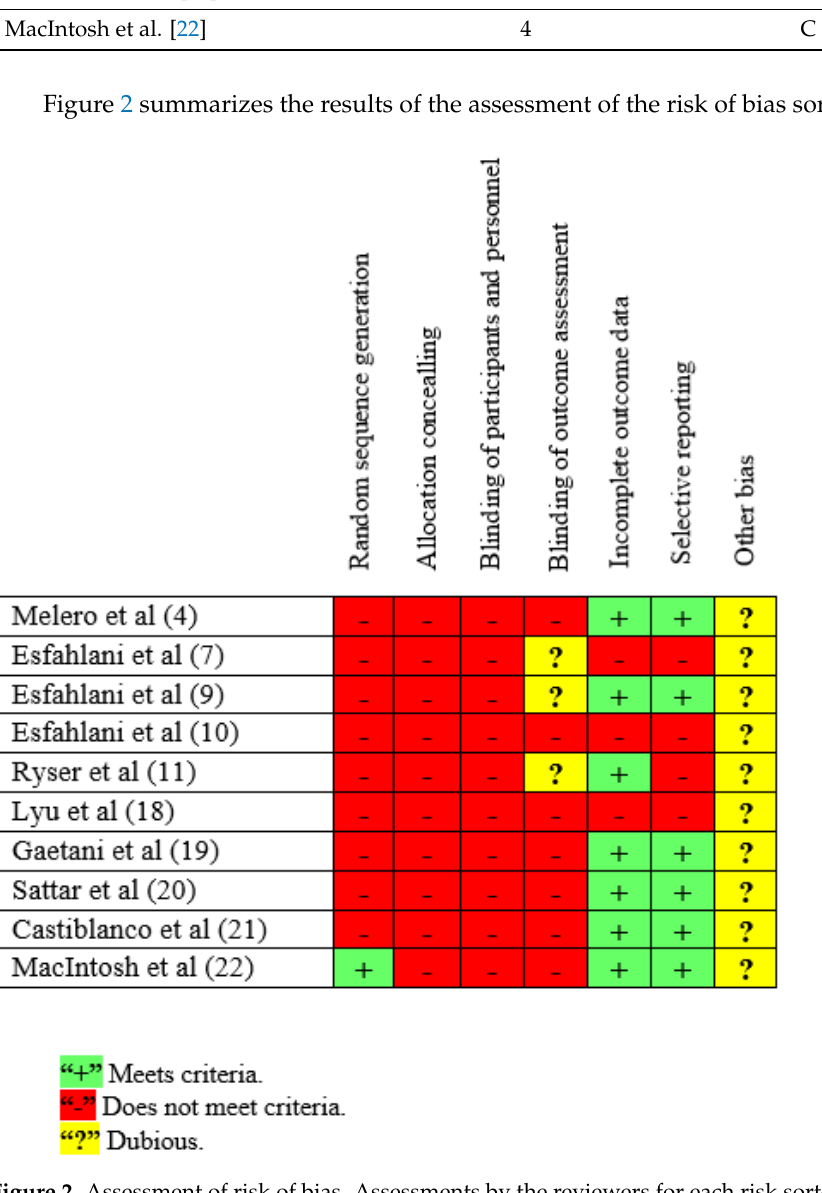
Figure 2. Assessment of risk of bias. Assessments by the reviewers for each risk sorted by article.